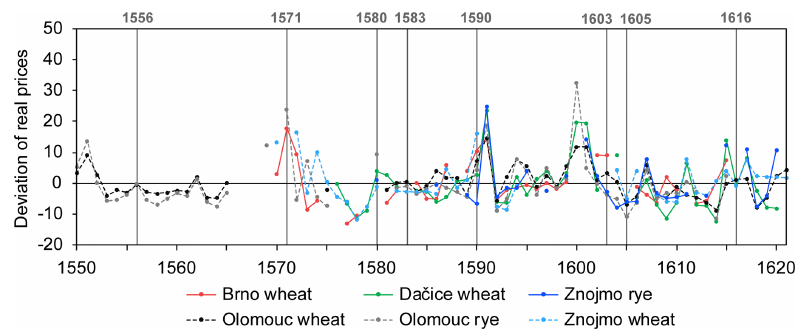
Figure 7. Deviations of real prices of purchase (full line) and sale (broken line) of wheat and rye in Brno, Daˇcice, Olomouc and Znojmo in the 1550–1621 period, with an identification of years of extreme drought.